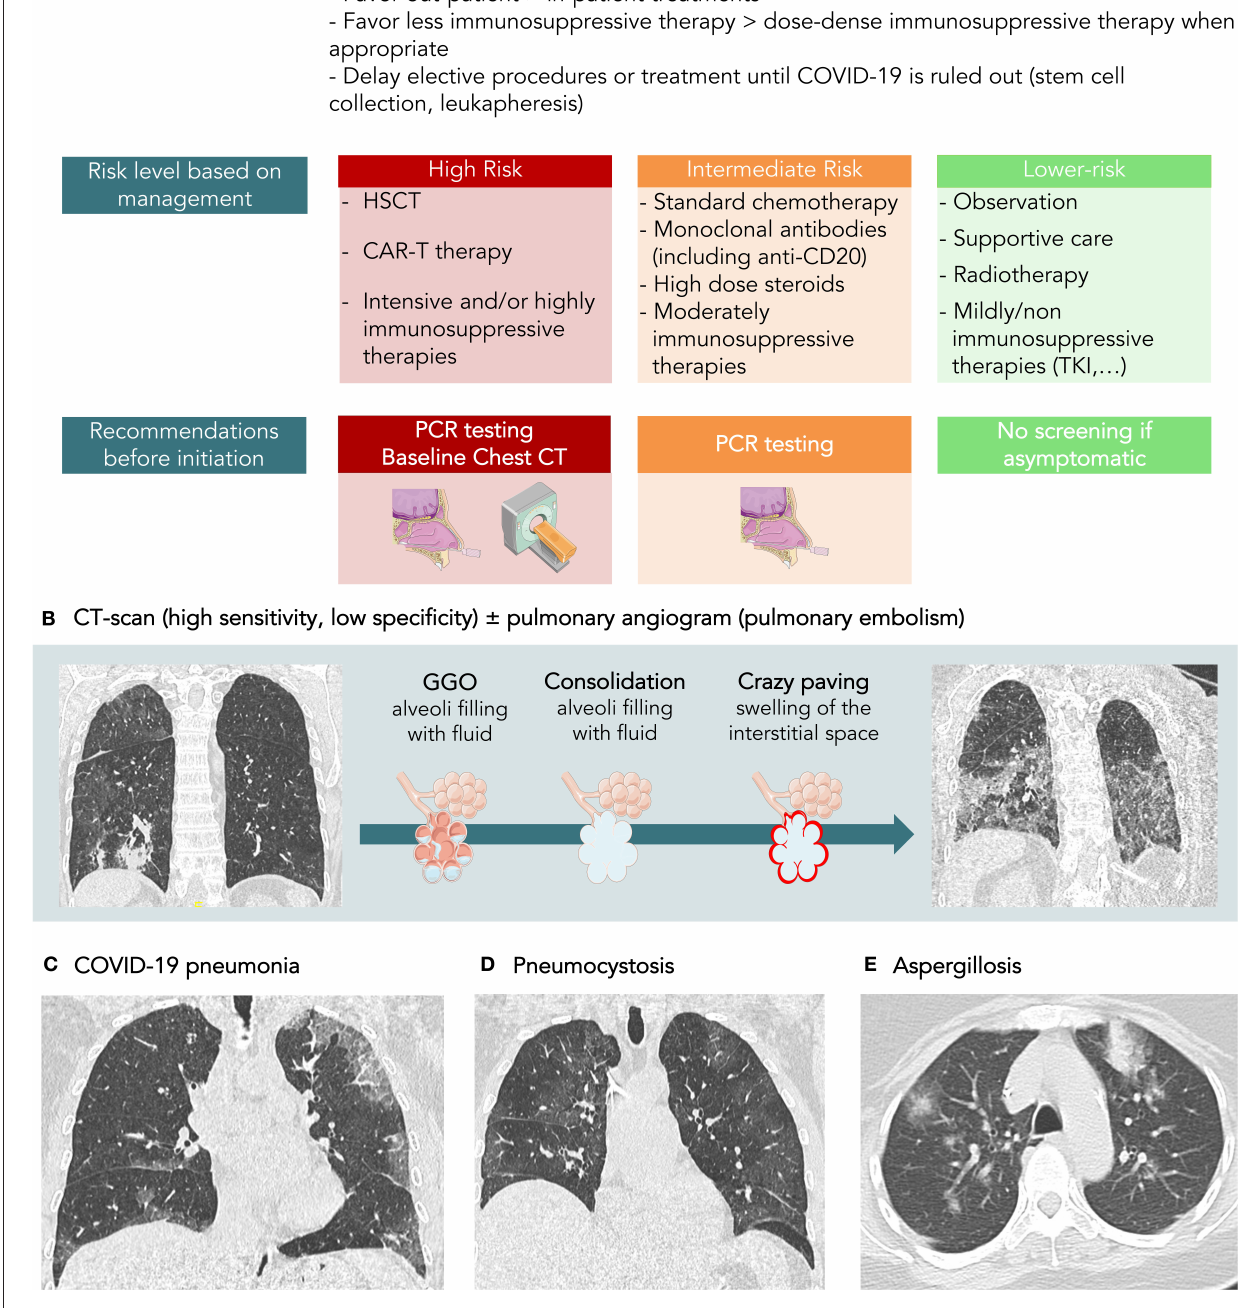
FIGURE 1 | (A) Proposed screening strategy for COVID-19 in patients with hematological malignancies. (B) CT-scan is a sensitive tool, but its specificity for the diagnosis of COVID-19 is around 37%, according to recent meta-analysis. It has not been evaluated in patients with hematological malignancies but could be even lower due to a higher rate of infection caused by immune suppression. (C) COVID-19 pneumonia in a 58-year-old patient with diffuse B lymphoma treated with R